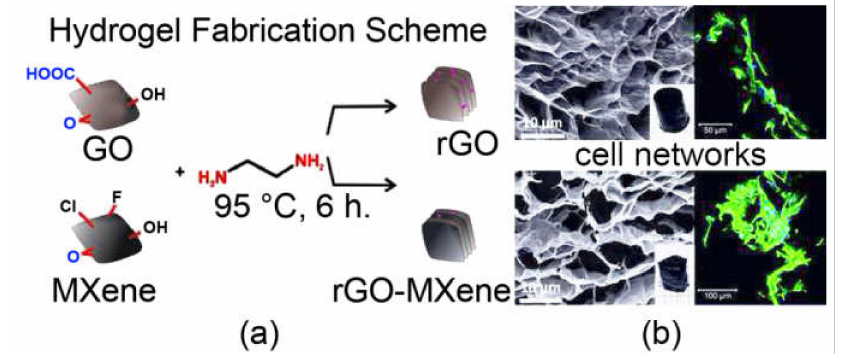
Figure 3. rGO-MXene hydrogels preparation ( a ) as scaffolds for cell networks ( b ). Adapted from Wychowaniec, J.K. et al. (2020) [102], under a Creative Commons license (https://creativecommons.